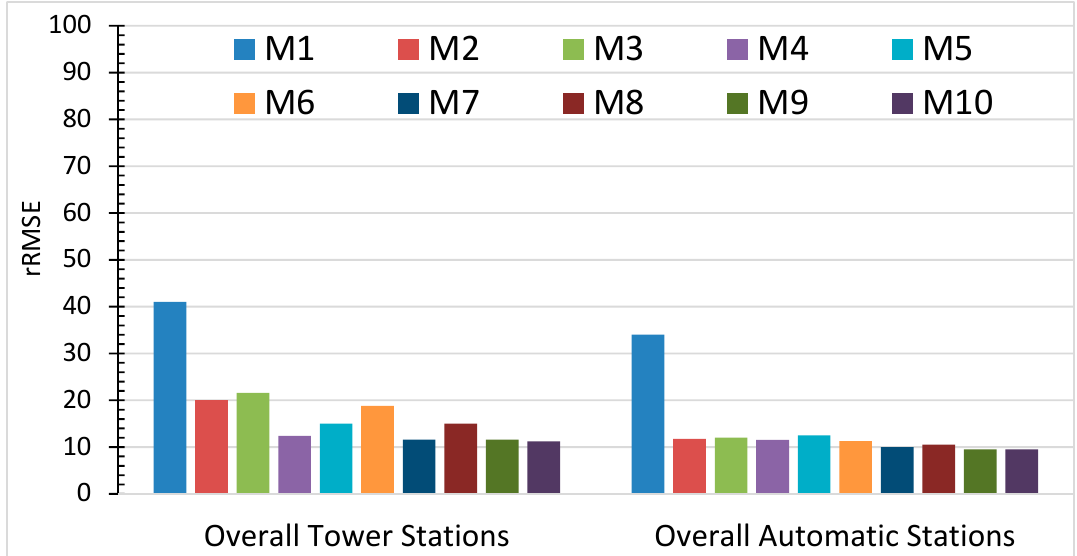
Figure 5. As in Figure 4, but for relative Root Mean Square Error (rRMSE).